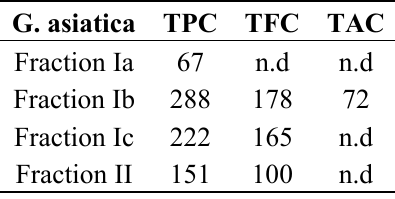
Table 7. Total phenolic, flavonoids and anthocyanin contents (mg/100 g) [47].